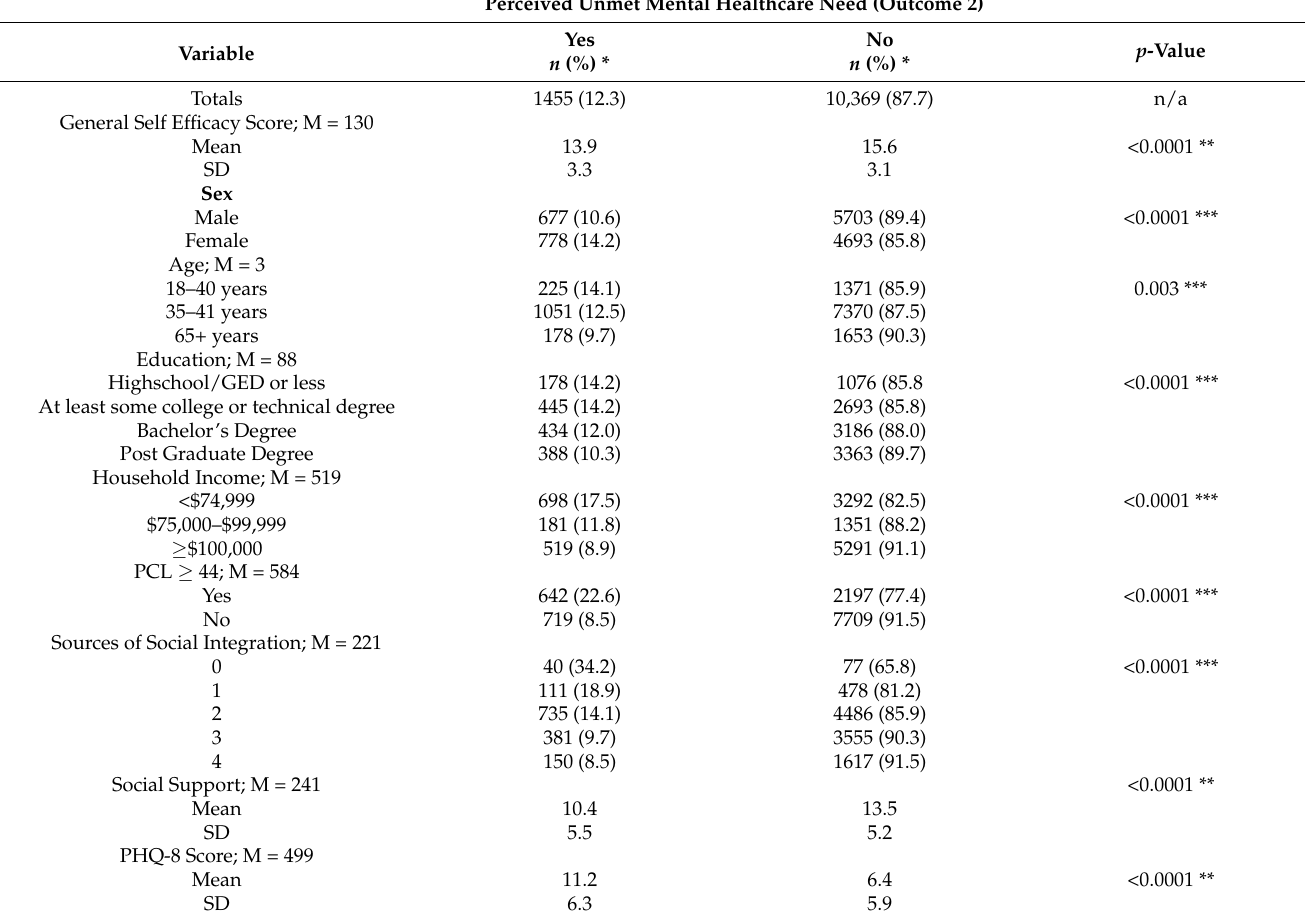
Table 3. Sociodemographic and Mental Health Characteristics of World Trade Center Health Registry Enrollees who had at Least one Session of Counselling or Therapy After 9/11, Stratified by Perceived Unmet Mental Healthcare Need (i.e., Outcome #2), 2015 to 2016 ( n = 11,851).